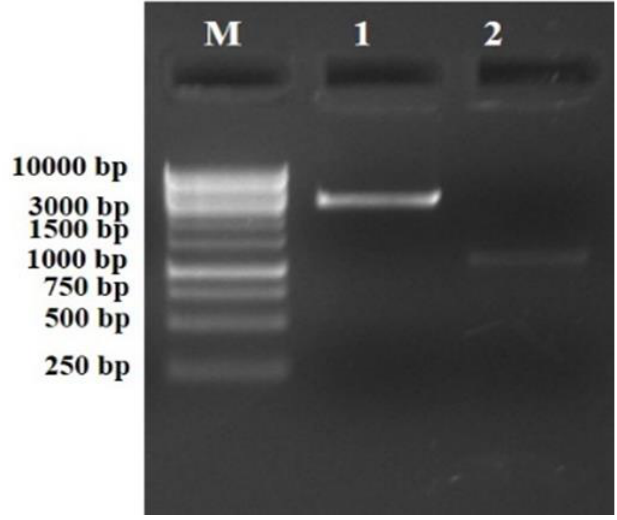
Figure 3. Restriction profile of the double-digested PCR product and control pBluescript vector.